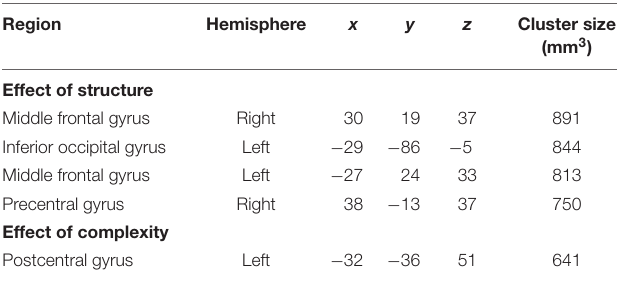
TABLE 1 | Effects of STRUCTURE and COMPLEXITY